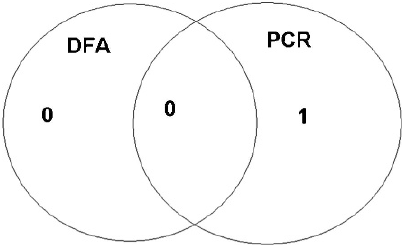
Figure 2 - Venn diagram from group B (1 positive PCR